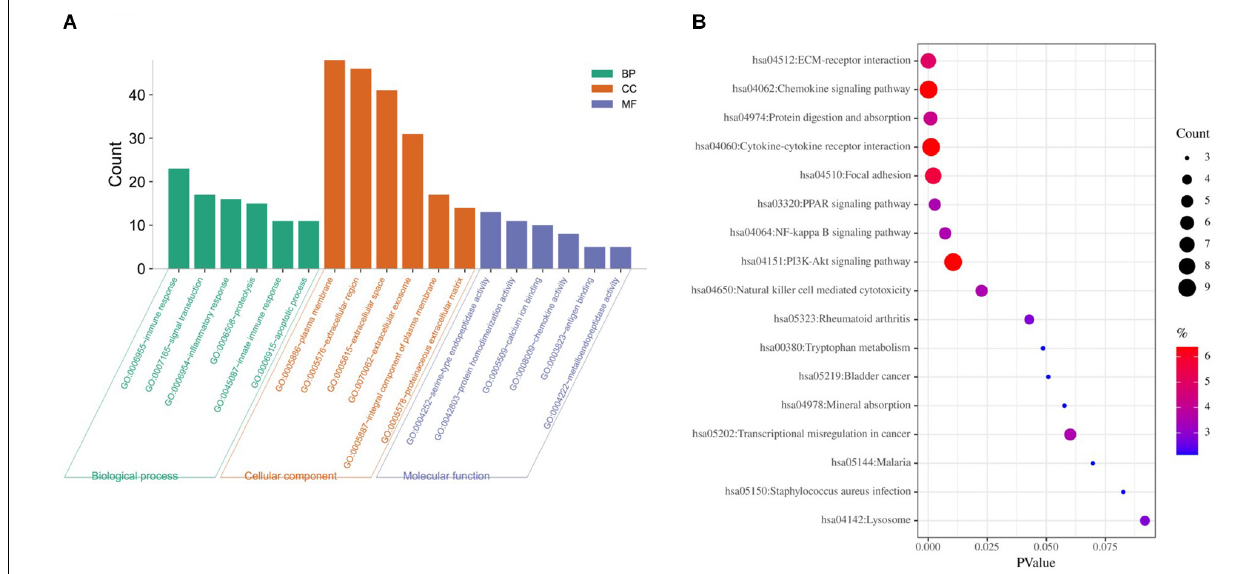
FIGURE 3 | GO and KEGG pathway enrichment analysis of DEGs between CAVD and normal controls. (A) The top six GO analysis results of DEGs. (B) Pathway analyses results of DEGs (top 20 according to adjusted P value). GO, gene ontology; KEGG, Kyoto Encyclopedia of Genes and